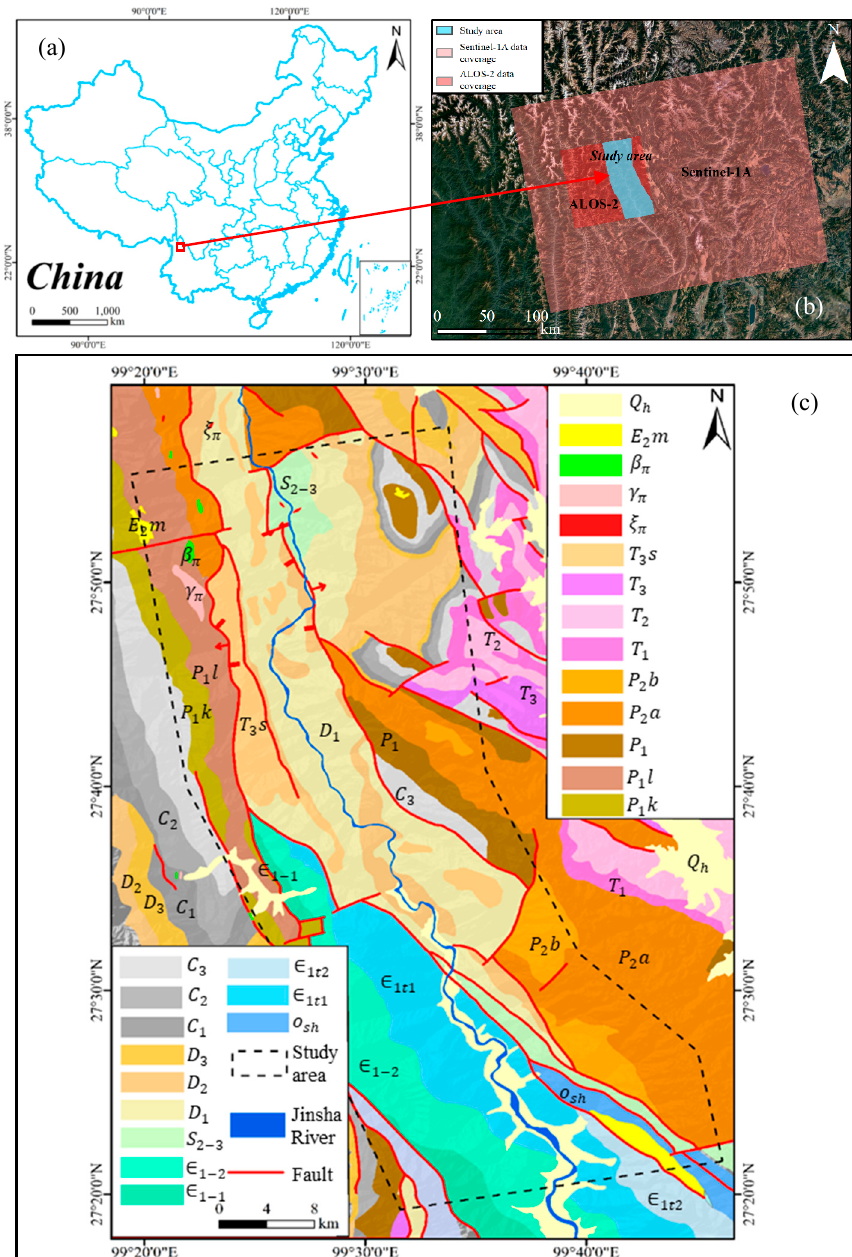
Figure 1. ( a ) The geographical location of the study area; ( b ) the coverage of the ALOS-2 and Sentinel-1A data; ( c ) the geological map of the study